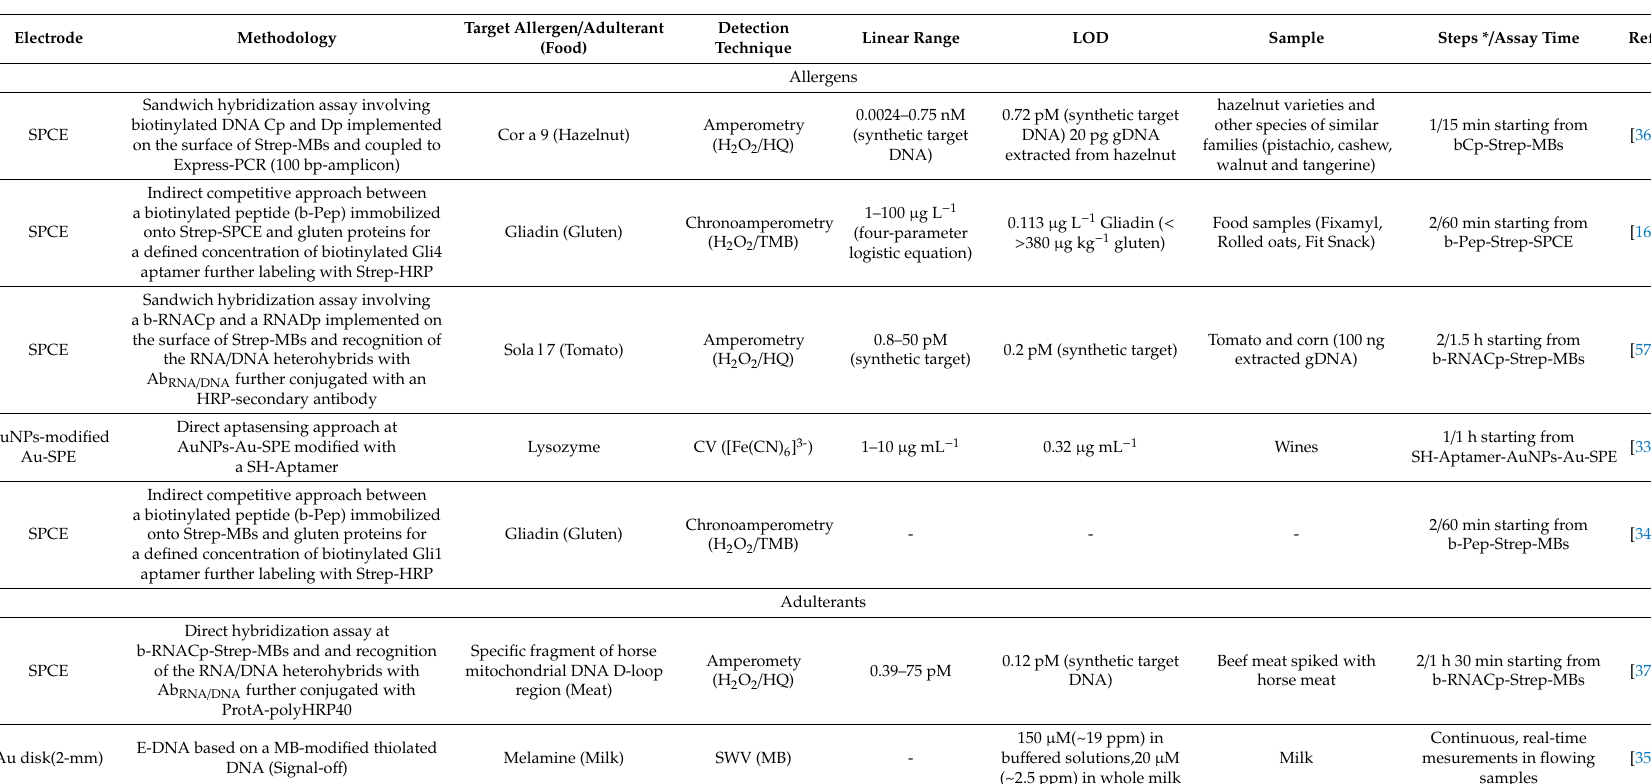
Table 2. Electrochemical nucleic acid-based biosensing methods reported since 2017 for the determination of food allergens and adulterants.